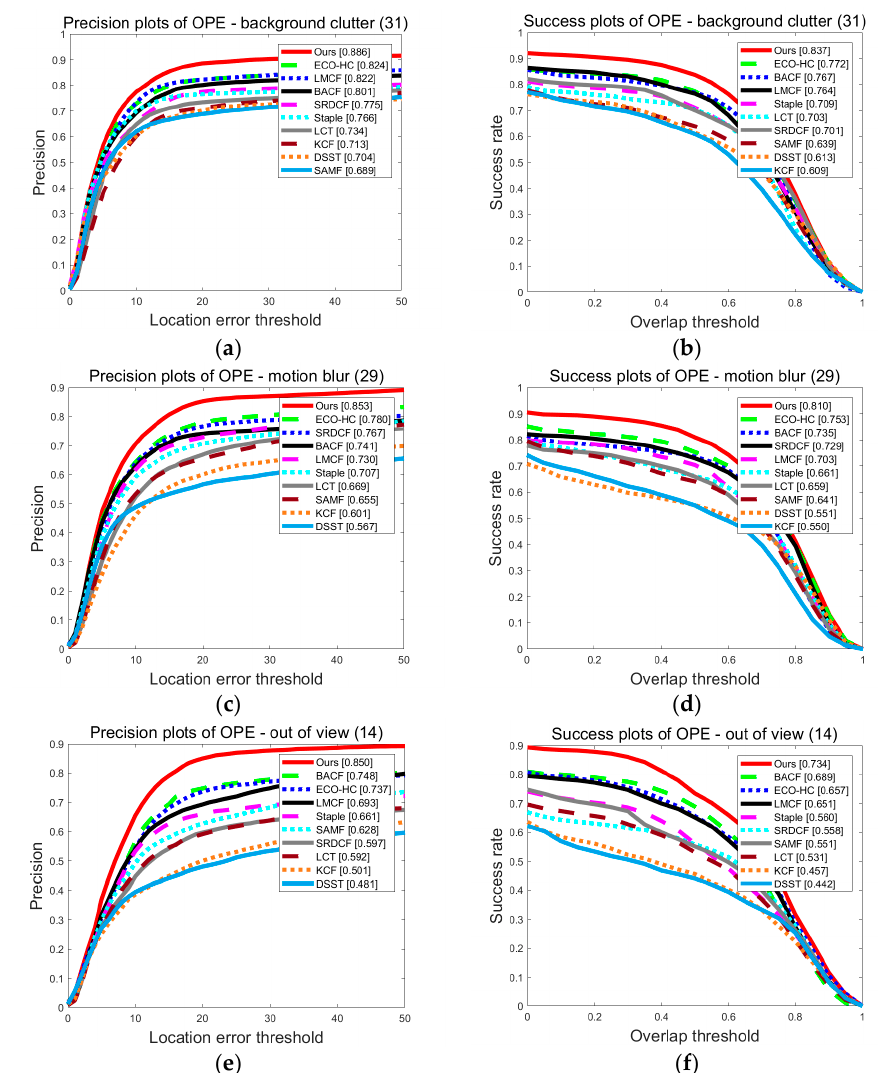
Figure 5. Experimental results show that the proposed tracker performs excellently, particularly in three attributes: ( a ) The PP of the OPE on attribute BC; ( b ) The SP of the OPE on attribute BC; ( c ) The PP of the OPE on attribute MB; ( d ) The SP of the OPE on attribute MB; ( e ) The PP of the OPE on attribute OV; ( f ) The SP of the OPE on attribute OV. OV; ( f ) The SP of the OPE on attribute OV.